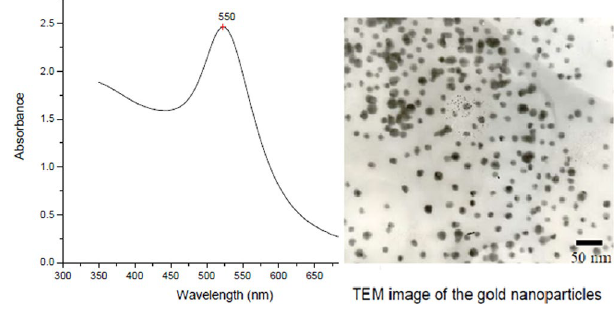
Figure 1. Characterization of AuNPs by UV-Vis spectrophotometer and